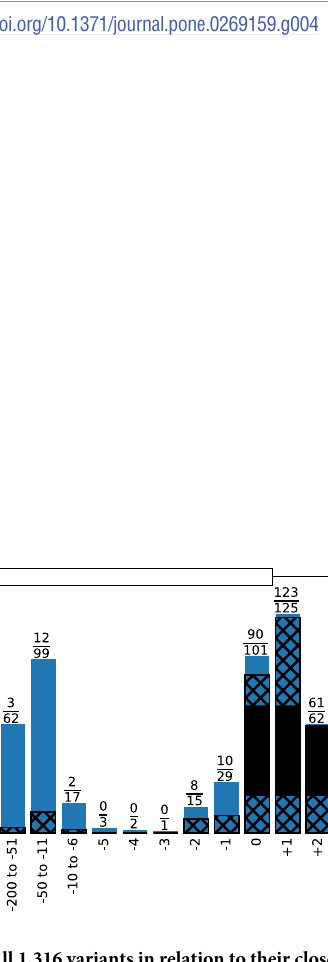
Fig 4. The final curated variant data set consists of 1,316 unique variants. (A) Literature sources of our data. There is an overlap of 8% of variants (mainly due to Houdayer et al. citing Leman et al.), all with consensus. (B) Split between splice affecting and non-affecting variants. (C) Split between negatively and positively stranded genes. (D) Variant location on chromosomes. Chromosomes 1, 11, 13, and 17 make up 73% of the variants. (E) Types of variants. (F) Split of non-SNV variant classes (7% of the whole data). (G) Functional impact of splicing variants. (H) Type of disruption for the 388 variants where the exact genomic location of the disruption is known (mostly exon skipping, with 19% using a specific alternative acceptor or donor site).